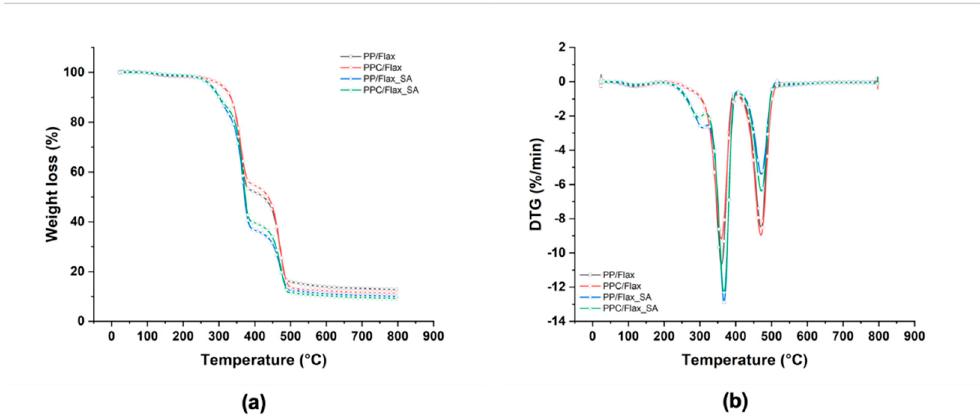
Figure 18. ( a ) TGA thermograms and ( b ) derivative thermogravimetry (DTG) curves of stearic-acid- treated flax fibers in a non-compatibilized (PP) or compatibilized (PPC)